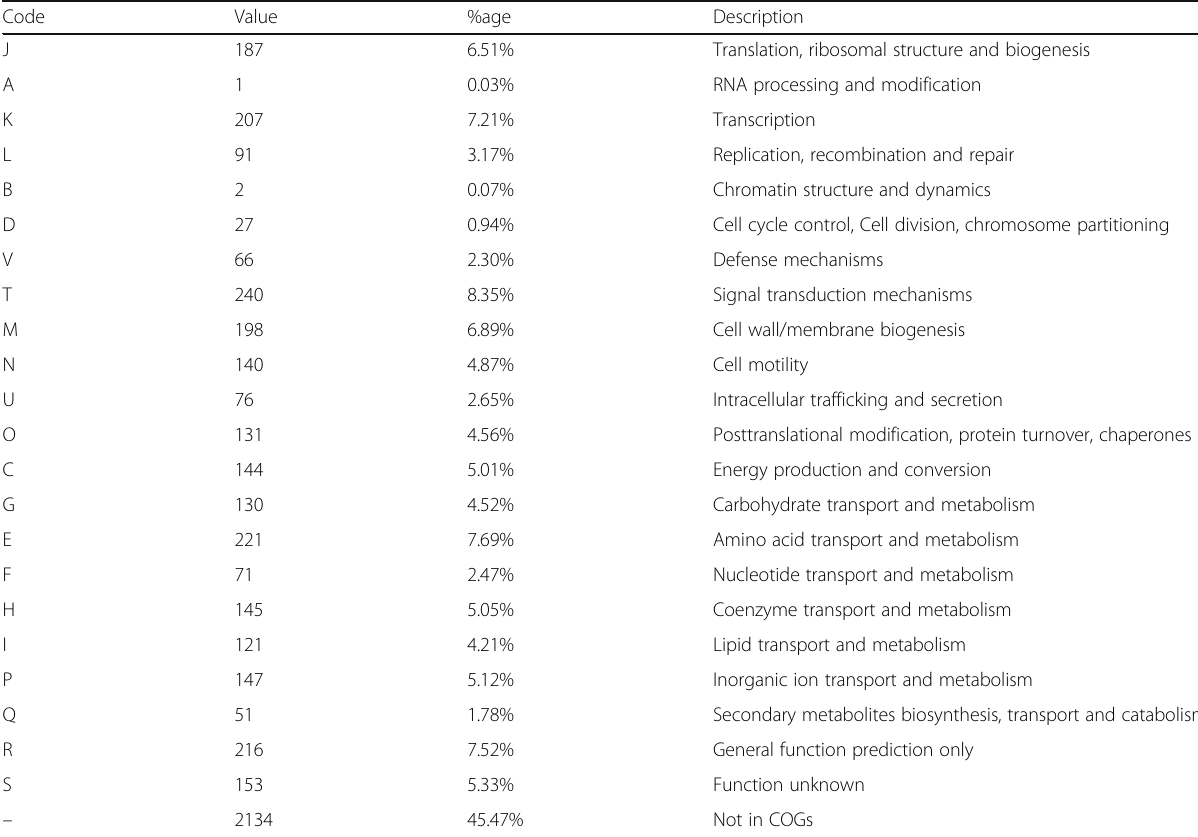
The total is based on the total number of protein coding genes in the genome